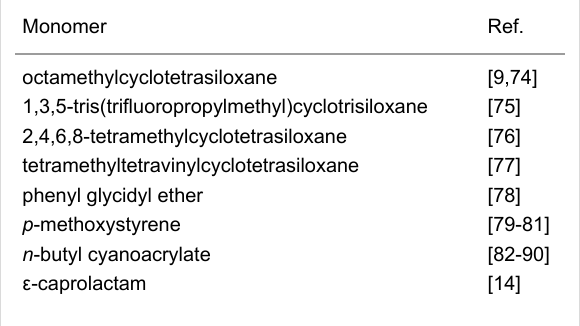
Table 5: Monomers employed for ionic polymerizations in miniemul-